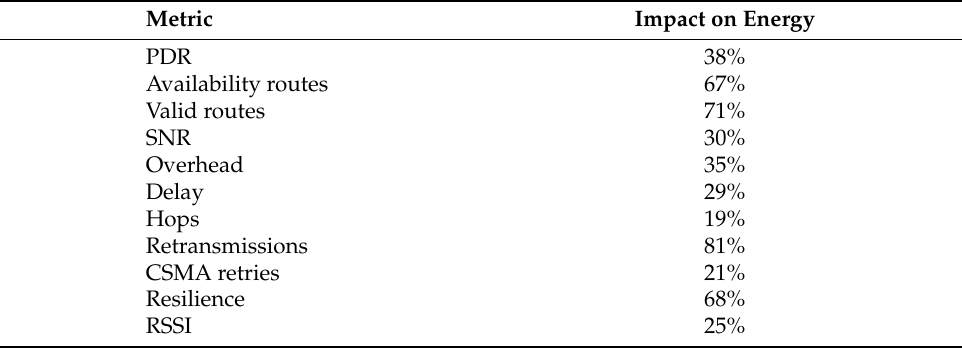
Table 4. Impact on energy for relevant performance